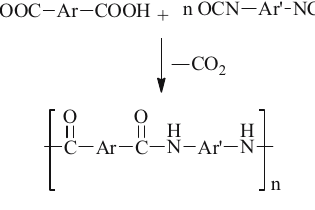
Scheme 5: Polycondensation of diacids and diisocyanates.